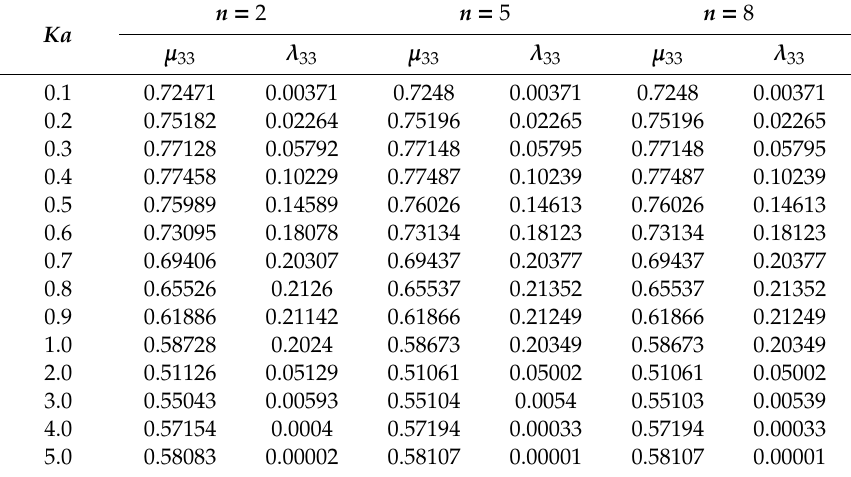
Table 2. Convergence sequence of the normalized heave added mass and damping coefficients for several mode numbers (Oblate spheroid with 𝑎/𝑏 = 1.25 and immersion 𝑓 = 1.5𝑎 ).